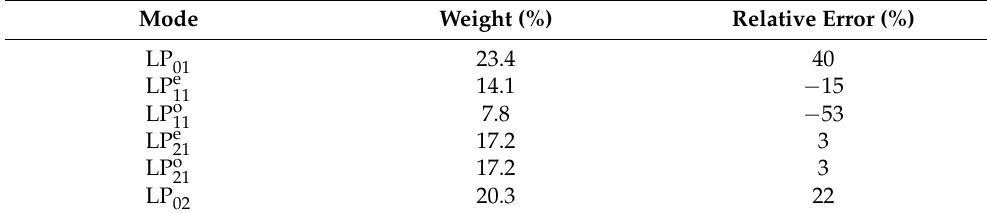
Table 1. Simulated modal weights (obtained with the W f function) and relative errors (obtained by comparing them with the ones determined through the W f,S function) following the simultaneous configuration of Figure 6 when all six LP-modes are equally present in the incident light.